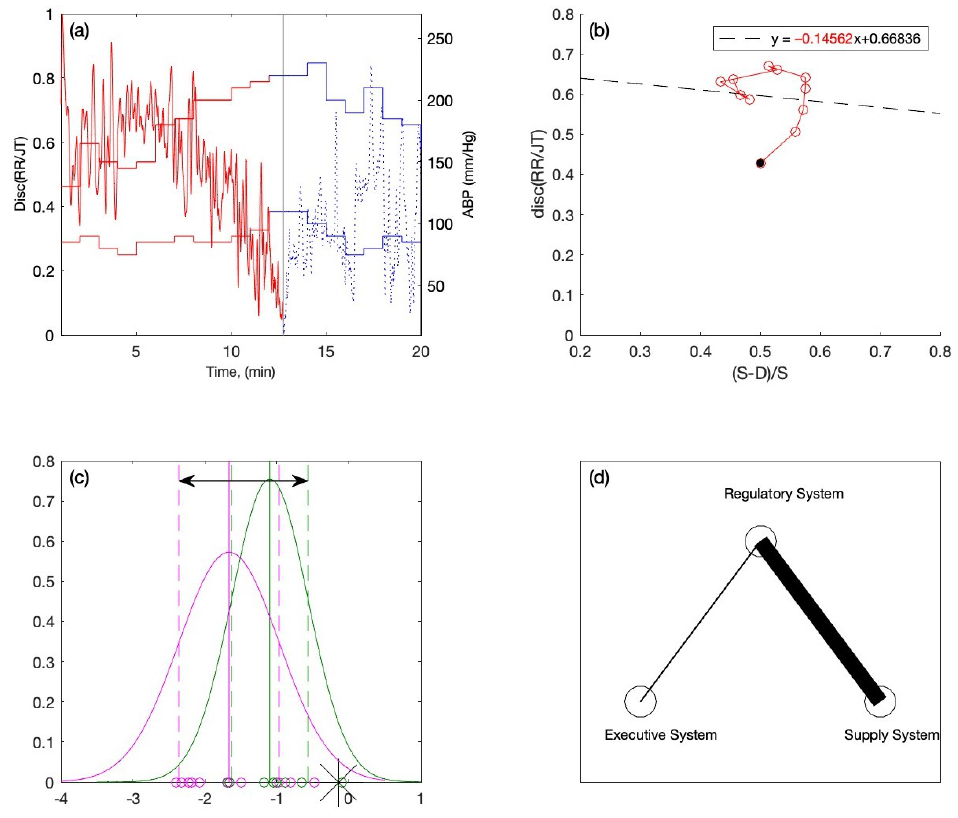
Figure 8. One case for an individual with ( a ) Discriminant RR/JT vs. time graph and ABP vs. time graph, ( b ) Linear regression graph and the slope coefficient ( − 0.14562) during the load phase, ( c ) Locating the individual within the variation interval of the Gaussian distribution graph, ( d ) Visualization of the individual inside the triangle